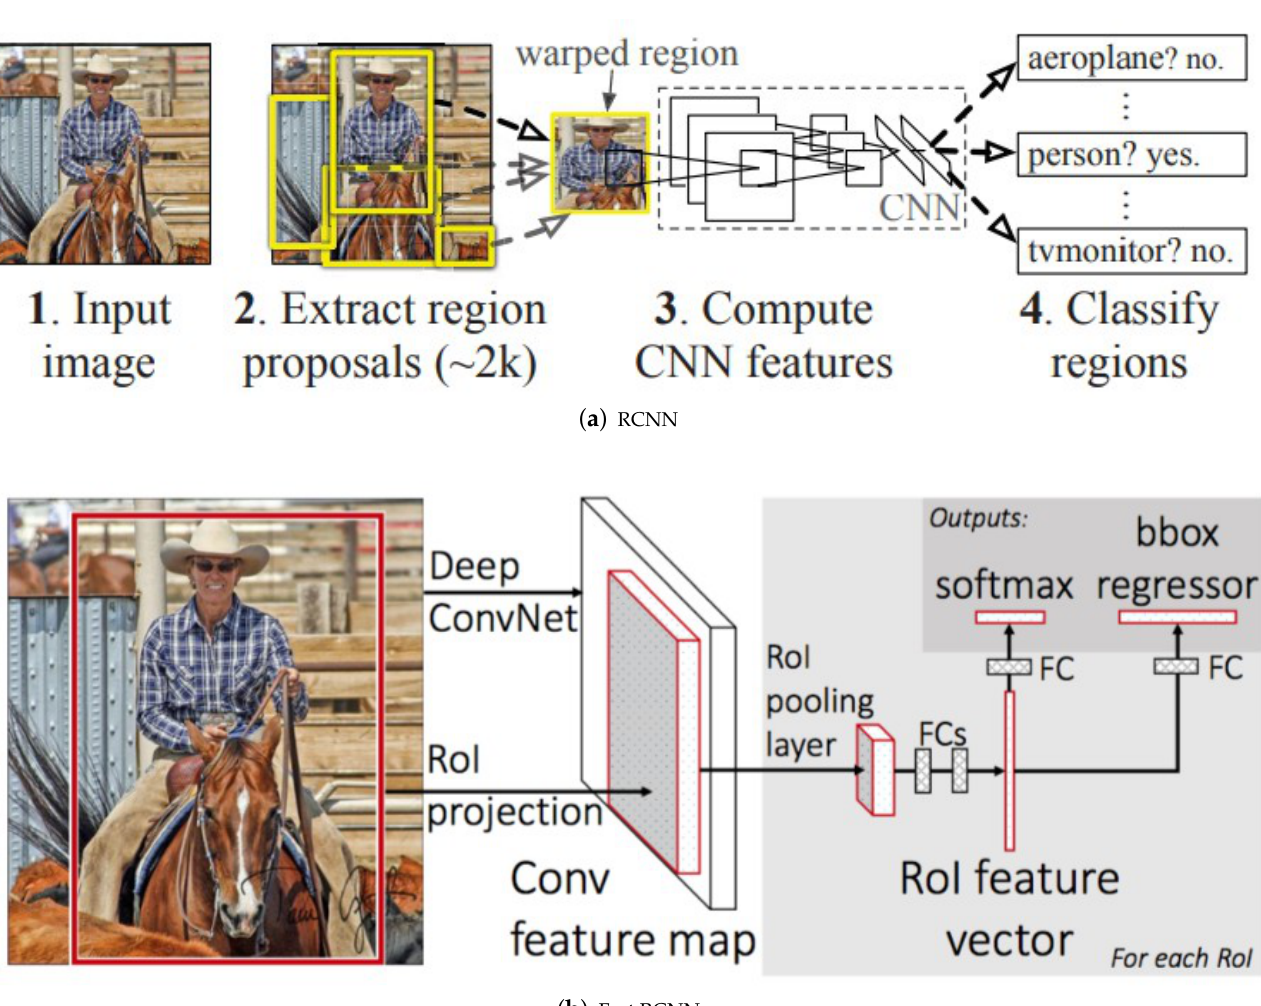
Figure 2. Architecture of RCNN and fast